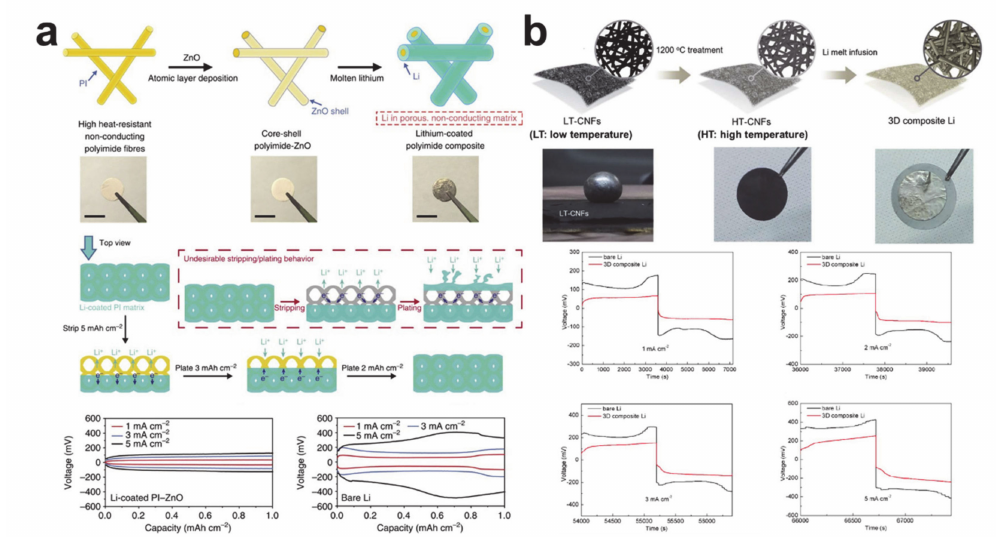
Figure 22. Lithium / nanofiber mat composite electrodes and their electrochemical performances. ( a ) Lithium / zinc oxide coated polyimide composite (reprinted with permission from [245]; copyright 2016 Springer Nature) and ( b ) lithium / carbon composite (reprinted with permission from [247]; copyright 2017 Royal Society of Chemistry).